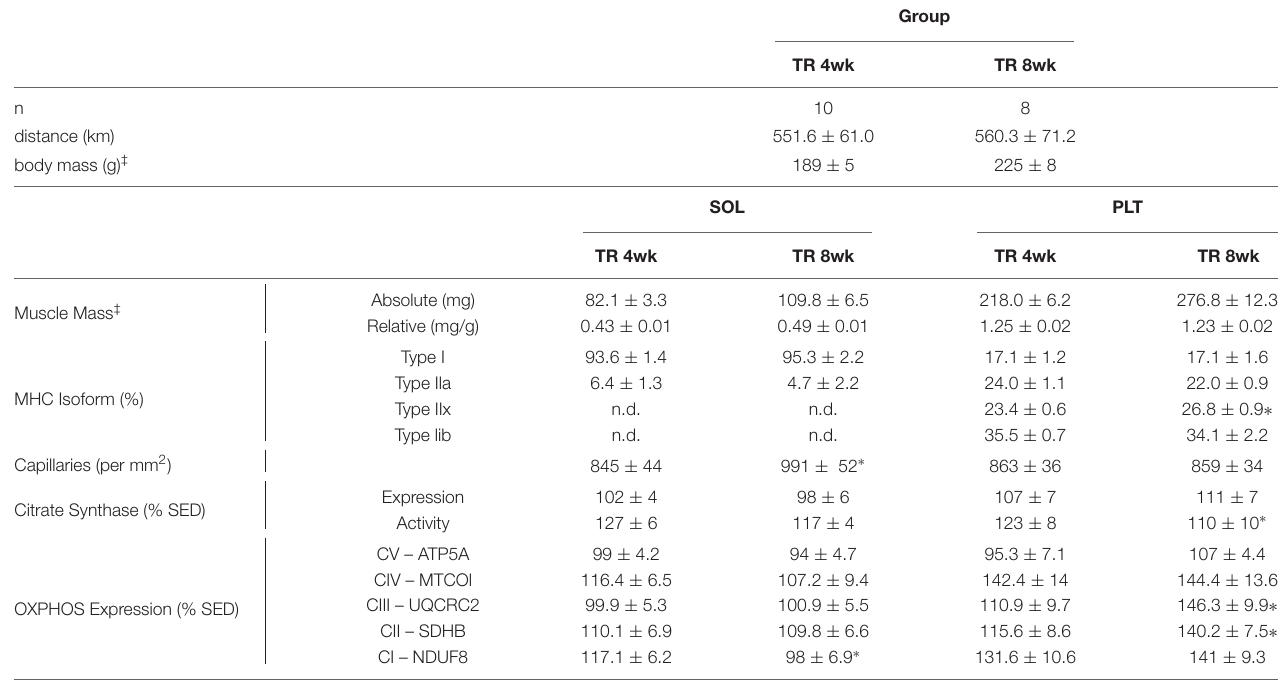
TABLE 2 | Mean ( ± SE) total running distance, body and muscle masses, myosin heavy chain (MHC) isoforms, total capillary counts, and mitochondrial proteins in adult female Sprague–Dawley rats after either four (TR 4wk) or 8 weeks (TR 8wk) of voluntary